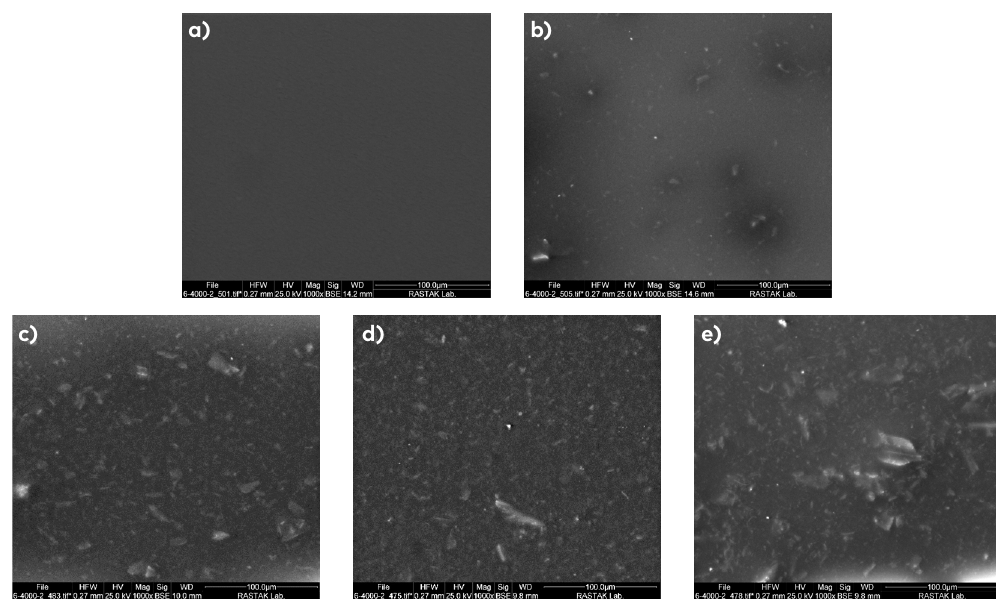
Figure 10. SEM image of asphalt binders: a) Neat bitumen, b) Neat bitumen + 2 wt%LUS-1, c) Neat bitumen + 4 wt%LUS-1, d) Neat bitumen